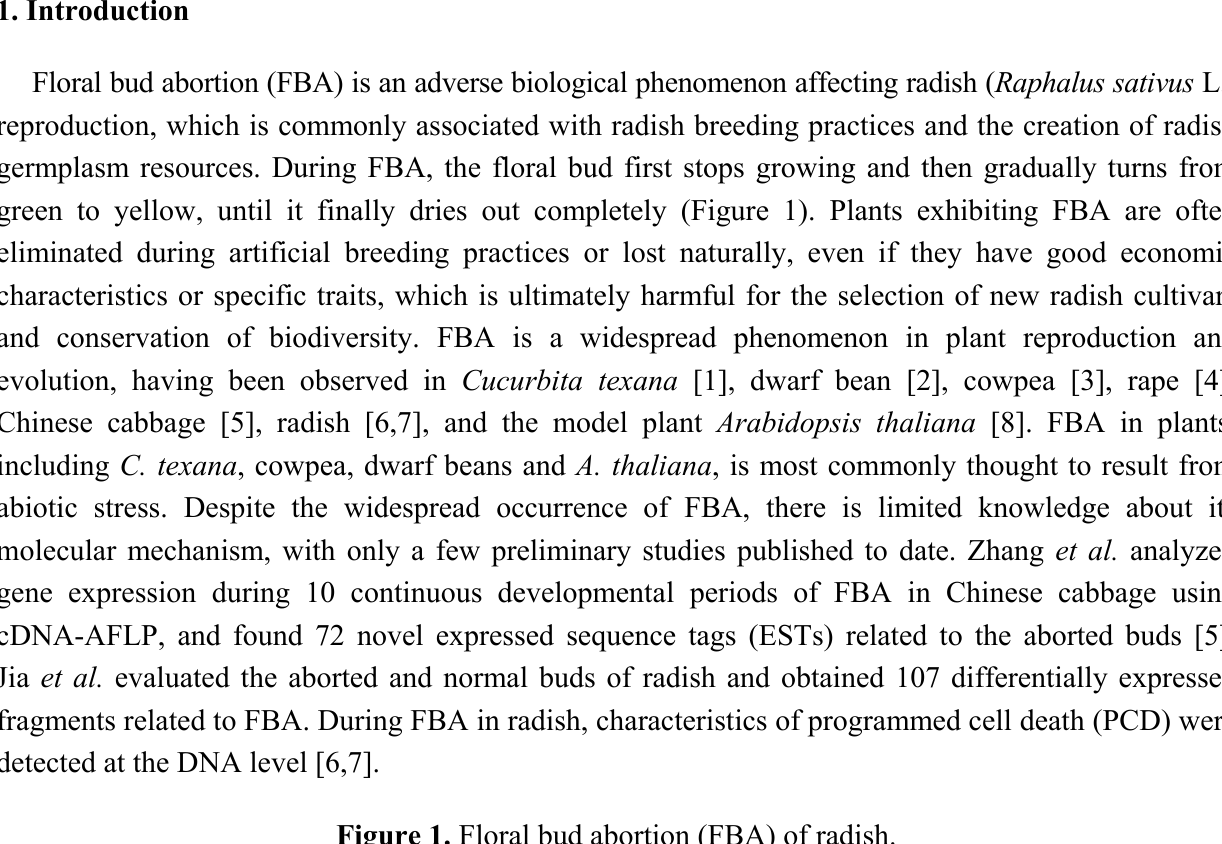
Figure 1. Floral bud abortion (FBA) of